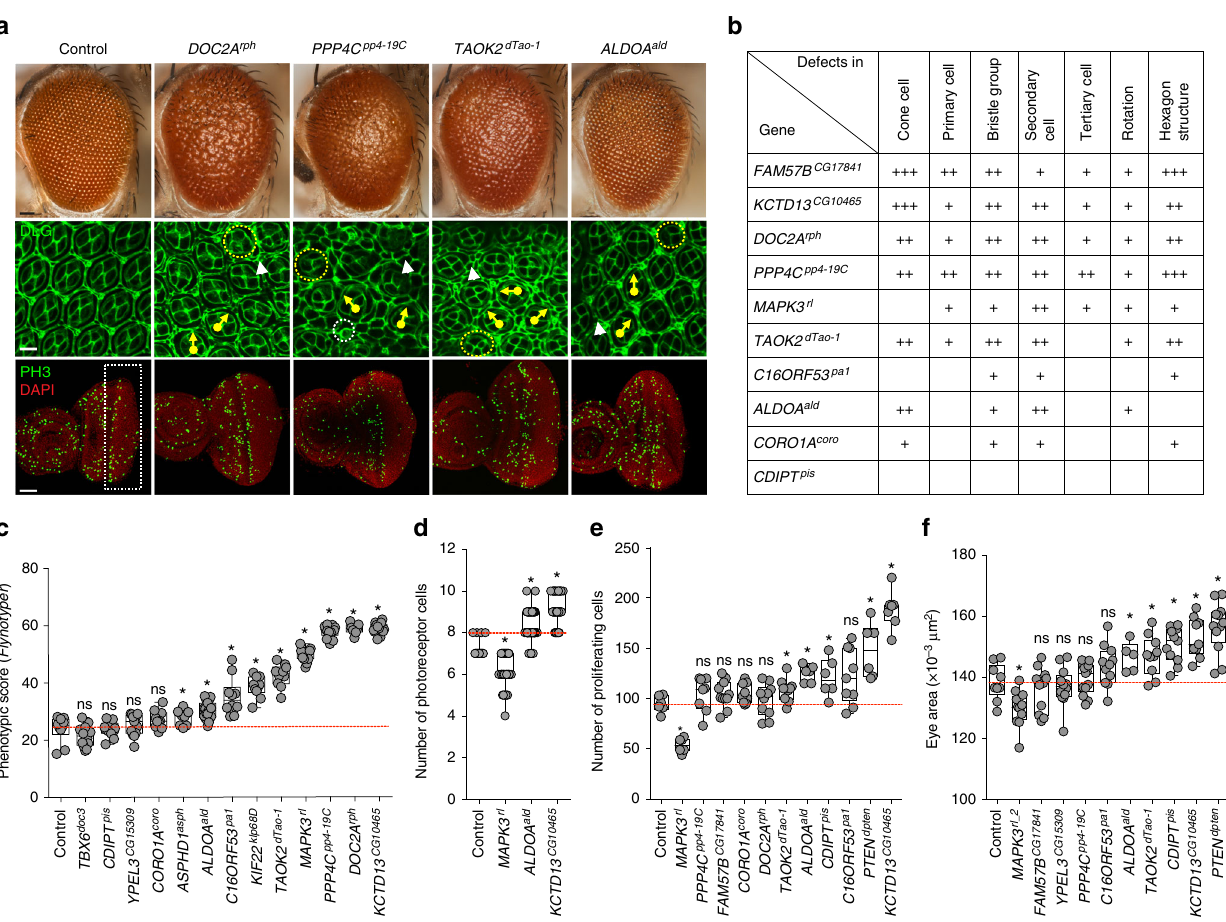
Fig. 5 Cellular phenotypes in the fl y eye due to knockdown of individual 16p11.2 homologs. a Representative bright fi eld adult eye images (scale bar = 50 µ m) and confocal images of pupal eye (scale bar = 5 µ m) and larval eye discs (scale bar = 30 µ m), stained with anti-Dlg and anti-pH3 respectively, of select 16p11.2 homologs illustrate defects in cell proliferation caused by eye-speci fi c knockdown of these homologs. b Table summarizing the cellular defects observed in the pupal eye of 16p11.2 homologs. “ + ” symbols indicate the severity of the observed cellular defects. c Box plot of Flynotyper scores for knockdown of 13 homologs of 16p11.2 genes with GMR-GAL4 > Dicer2 ( n = 7 – 19, * p < 0.05, Mann – Whitney test). FAM57B CG17841 knockdown displayed pupal lethality with Dicer2 , and therefore the effect of gene knockdown in further experiments was tested without Dicer2 . d Box plot of photoreceptor cell count in the pupal eyes of 16p11.2 knockdown fl ies ( n = 59 – 80, * p < 0.05, Mann – Whitney test). e Box plot of pH3-positive cell count in the larval eyes of 16p11.2 knockdown fl ies ( n = 6 – 11, * p < 0.05, Mann – Whitney test). f Box plot of adult eye area in 16p11.2 one-hit knockdown models ( n = 5-13, * p < 0.05, Mann – Whitney test). All boxplots indicate median (center line), 25th and 75th percentiles (bounds of box), and minimum and maximum